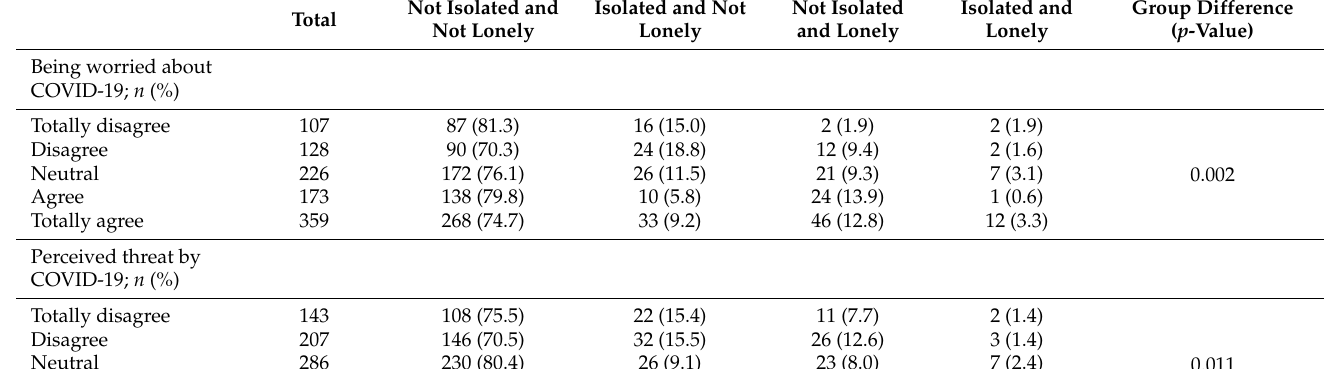
Not Isolated and Isolated and Not Not Isolated Isolated and Group Difference Total Not Lonely Lonely and Lonely Lonely ( p